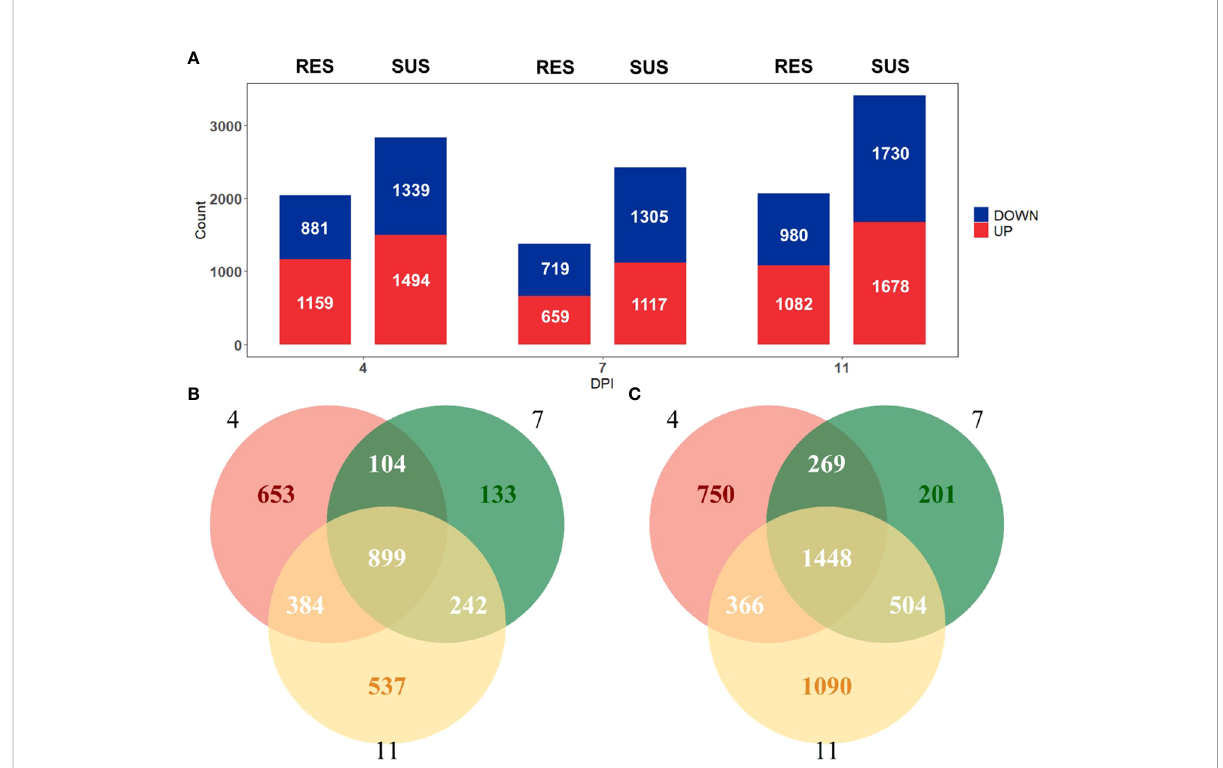
FIGURE 2 (A) Number of genes differentially expressed (|log2(FoldChange)| > 1 and adjusted p-value < 0.05) relative to day 0 in resistant (left) and susceptible (right) pigs on days 4, 7 and 11 post-infection. (B) Venn diagram comparing identi fi ed DEGs in resistant pigs. (C) Venn diagram comparing identi fi ed DEGs in susceptible